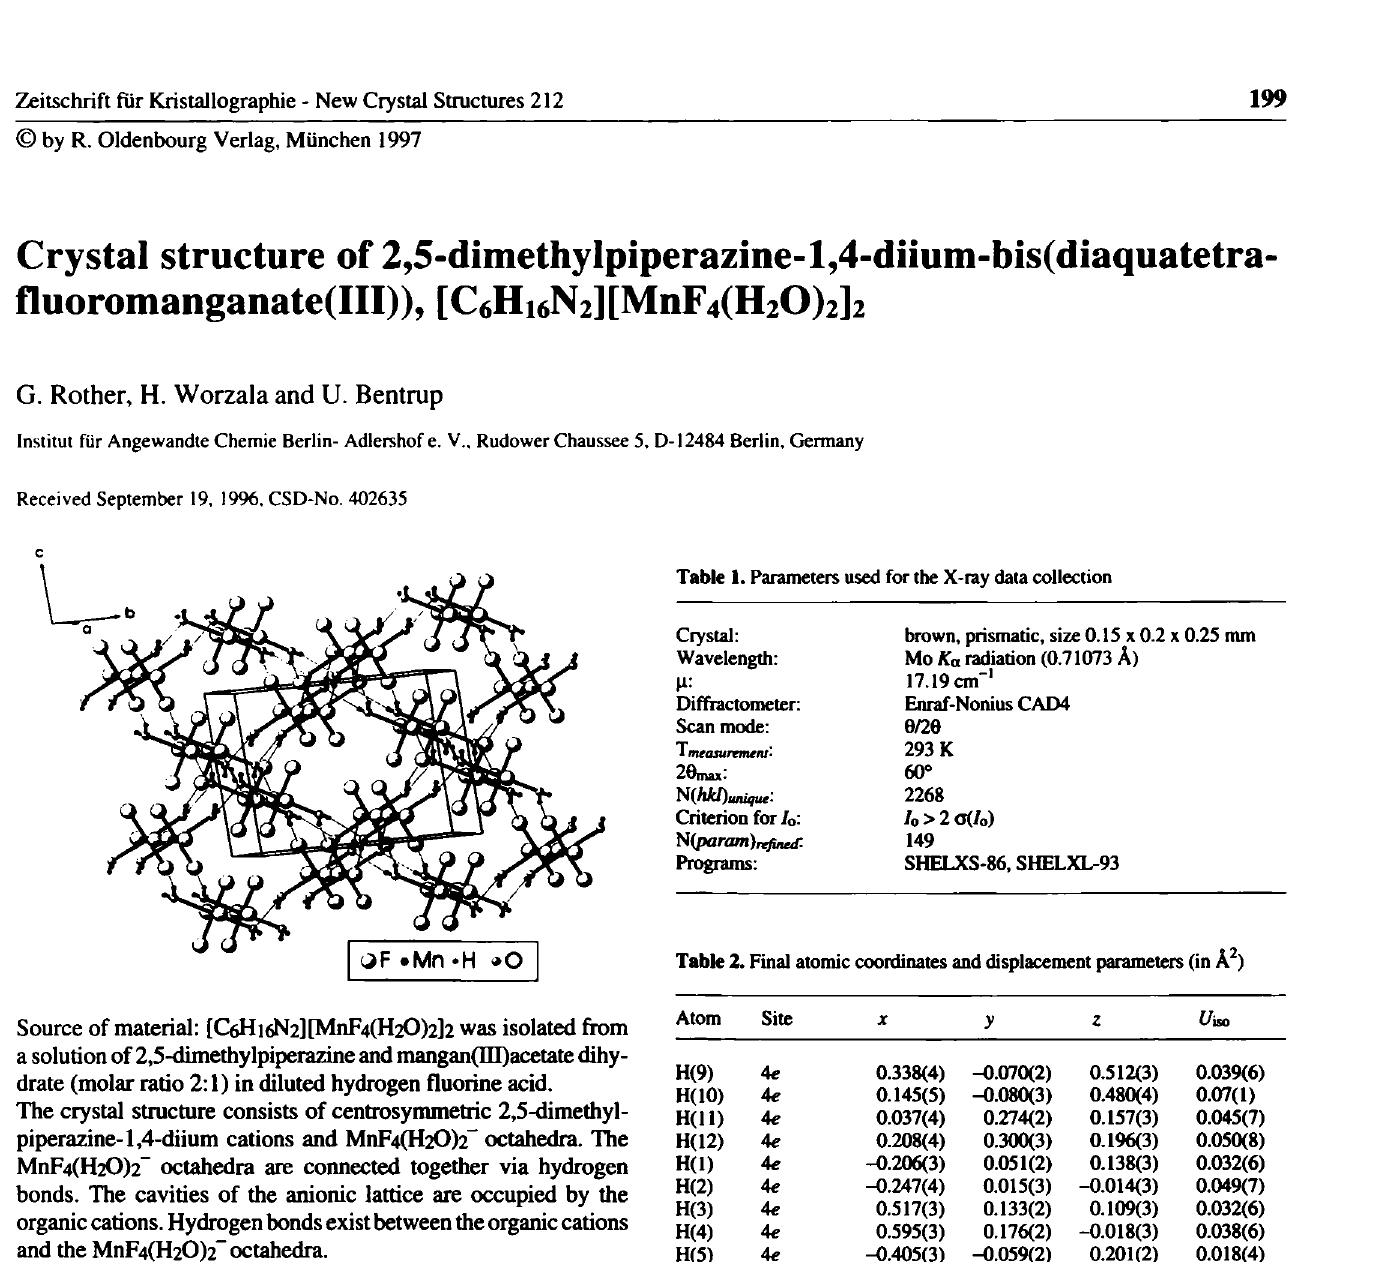
Table 2. Final atomic coordinates and displacement parameters (in Â 2